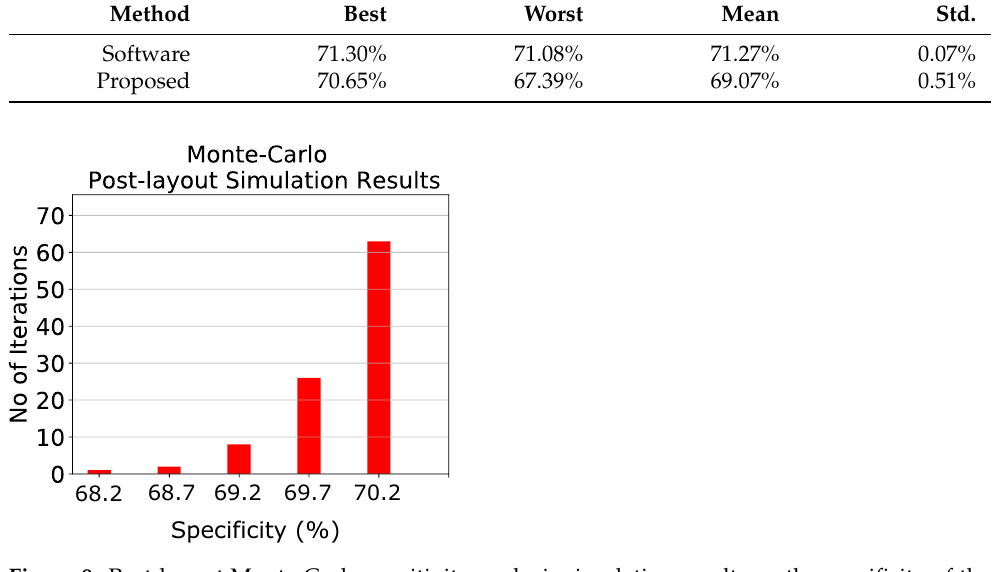
Figure 9. Post-layout Monte-Carlo sensitivity analysis simulation results on the specificity of the classifier for one of the previous 20